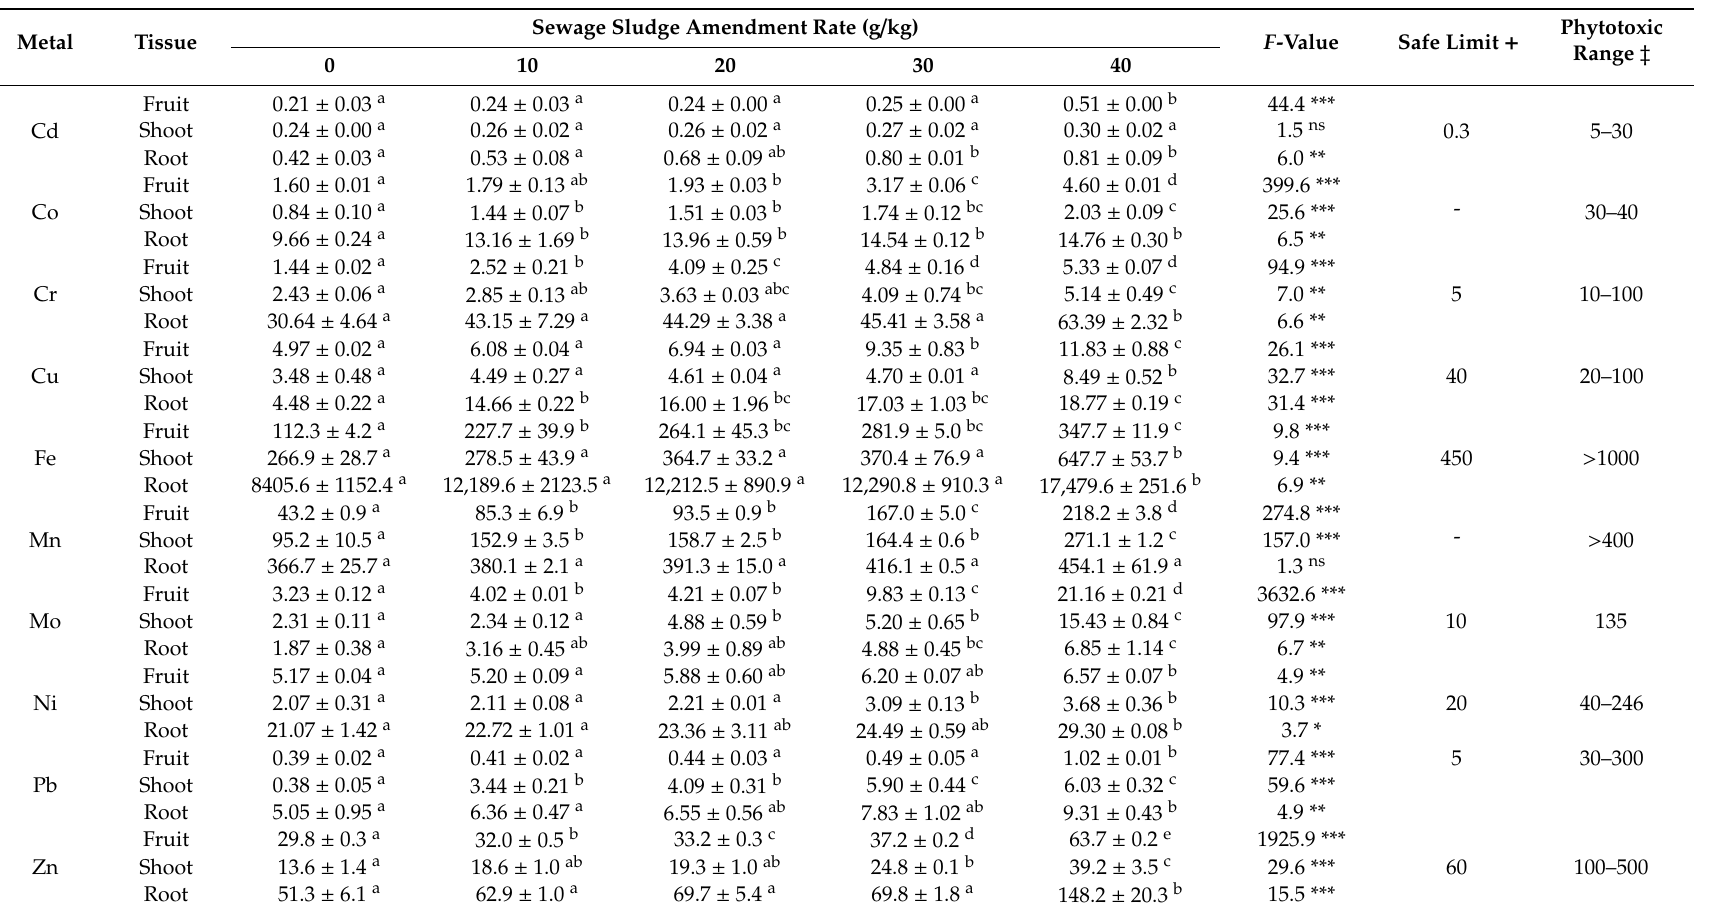
Table 3. E ff ects of di ff erent amendment rates of sewage sludge on heavy metal concentrations (mg / kg) in fruits, shoots, and roots of Pisum sativum plants that were harvested after 57 days (means ± standard error, n =